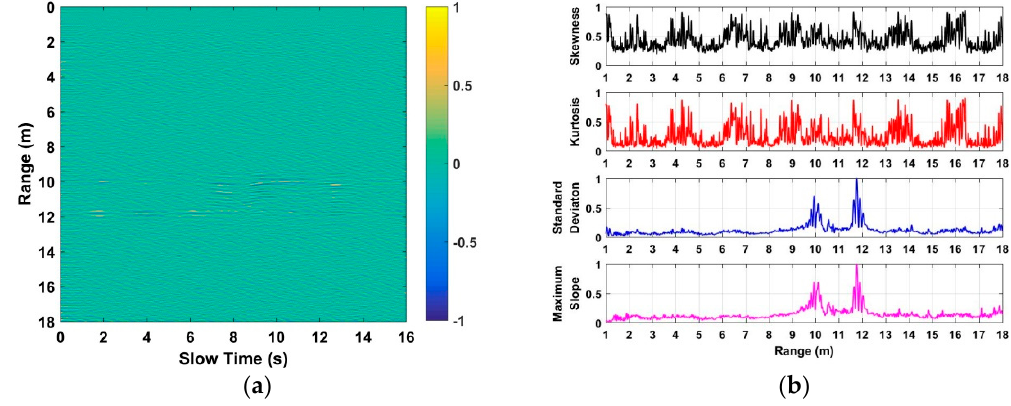
Figure 17. Results of the detection of two human beings ( a ) after removing clutter; and ( b ) distance estimates.